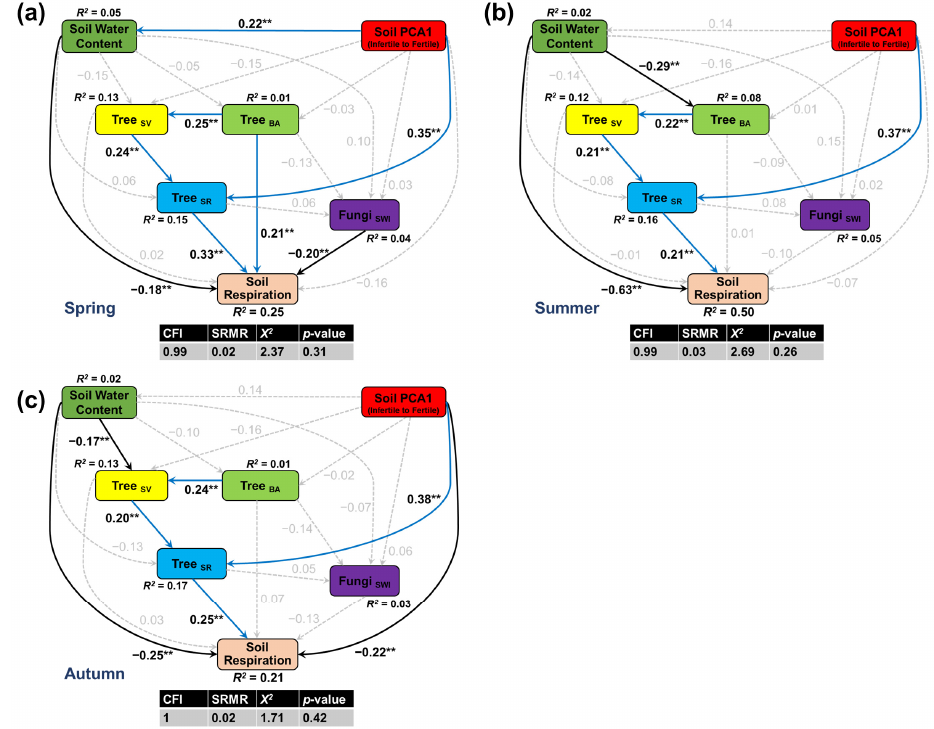
Figure 2. Structural equation models showing differences in soil respiration in spring ( a ), summer ( b ), and autumn ( c ) associated with soil moisture (soil water content), total soil elements (soil PCA1), plant biomass (Tree BA ), stand structural complexity (Tree SV ), plant diversity (Tree SR ), and soil fungal diversity (Fungi SWI ). Blue and black solid arrows represent significant positive or negative paths, respectively, at p < 0.05 (** p < 0.05); grey dashed arrows indicate non-significant paths. Values adjacent to arrows represent standardized coefficients (see Table S6). All abbreviations follow Table 1.